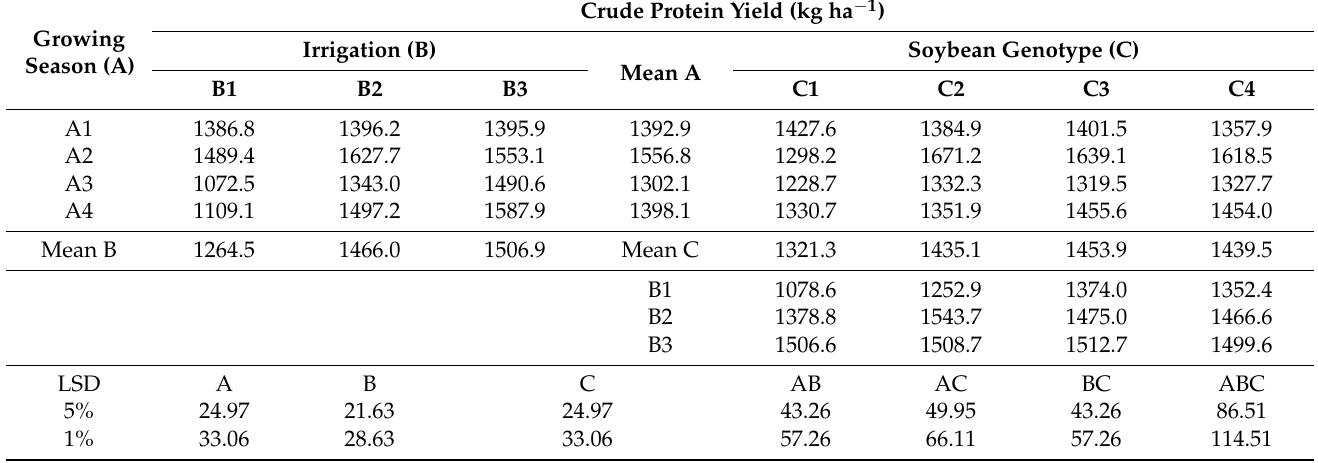
Table 4. Impacts of the environmental conditions in the four growing seasons (A1–A4), three treatments (B1, rain-fed conditions; B2, 60% of the field water capacity, or FWC; B3, 80–100% of the FWC), four genotypes (C1–C4) and their interactions (AB, AC, BC and ABC) on soybean crude protein yield (kg ha − 1